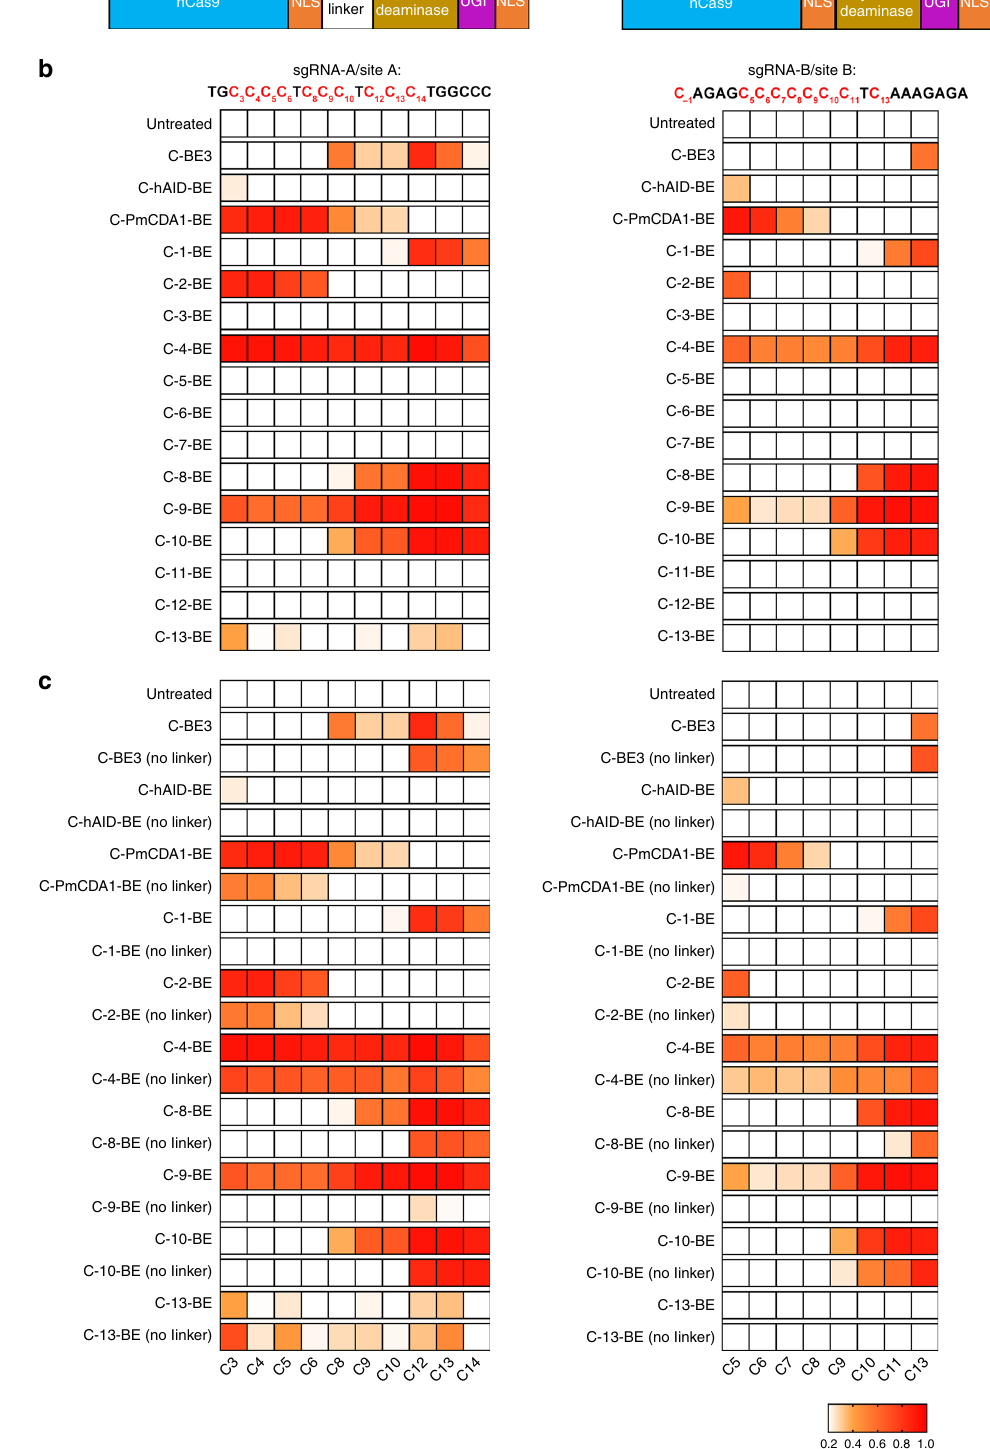
Fig. 3 Screening of base editing activities for CT-CBEs with/without the linker. a Organization of CT-CBEs. CT-CBEs were generated by fusing different cytidine deaminases to the C – terminus of nCas9. The 100 a.a. – length linker was inserted between nCas9 and cytidine deaminases, which was depleted in CT-CBEs (no linker). b Screening for the editing ef fi ciencies of all CT-CBEs with the linker. c The linker was depleted in functional CT-CBEs (called CT-CBEs (no linker)) and their editing ef fi ciencies were quanti fi ed and compared with the corresponding CT-CBEs. Two sgRNAs, sgRNA-A/B, and Sanger sequencing were used to evaluate the editing activities of CT-CBEs with/without the linker and C – T conversion frequencies at every cytosine located in regions 20bp upstream of PAM sites were quanti fi ed with EditR. Heat map showed the editing ef fi ciencies for the critical C sites. Several C sites were not shown because of their low editing ef fi ciencies for all CT-CBEs tested in this study. Source data are provided as a Source Data fi